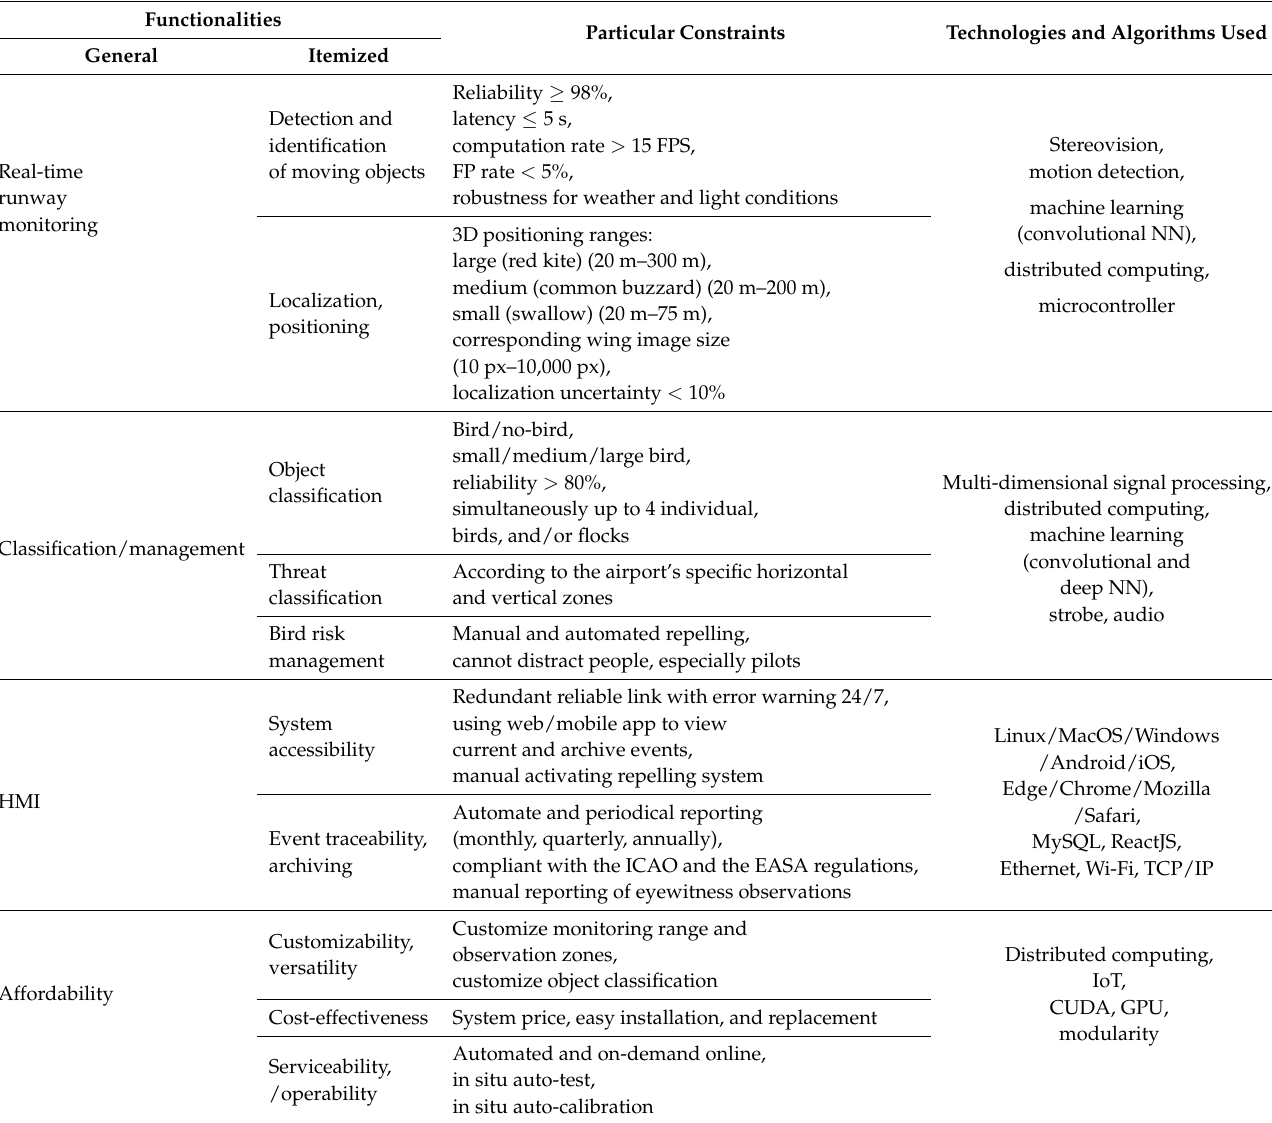
Table 1. UDD summary: functionalities, constraints, and applied technologies and algorithms.